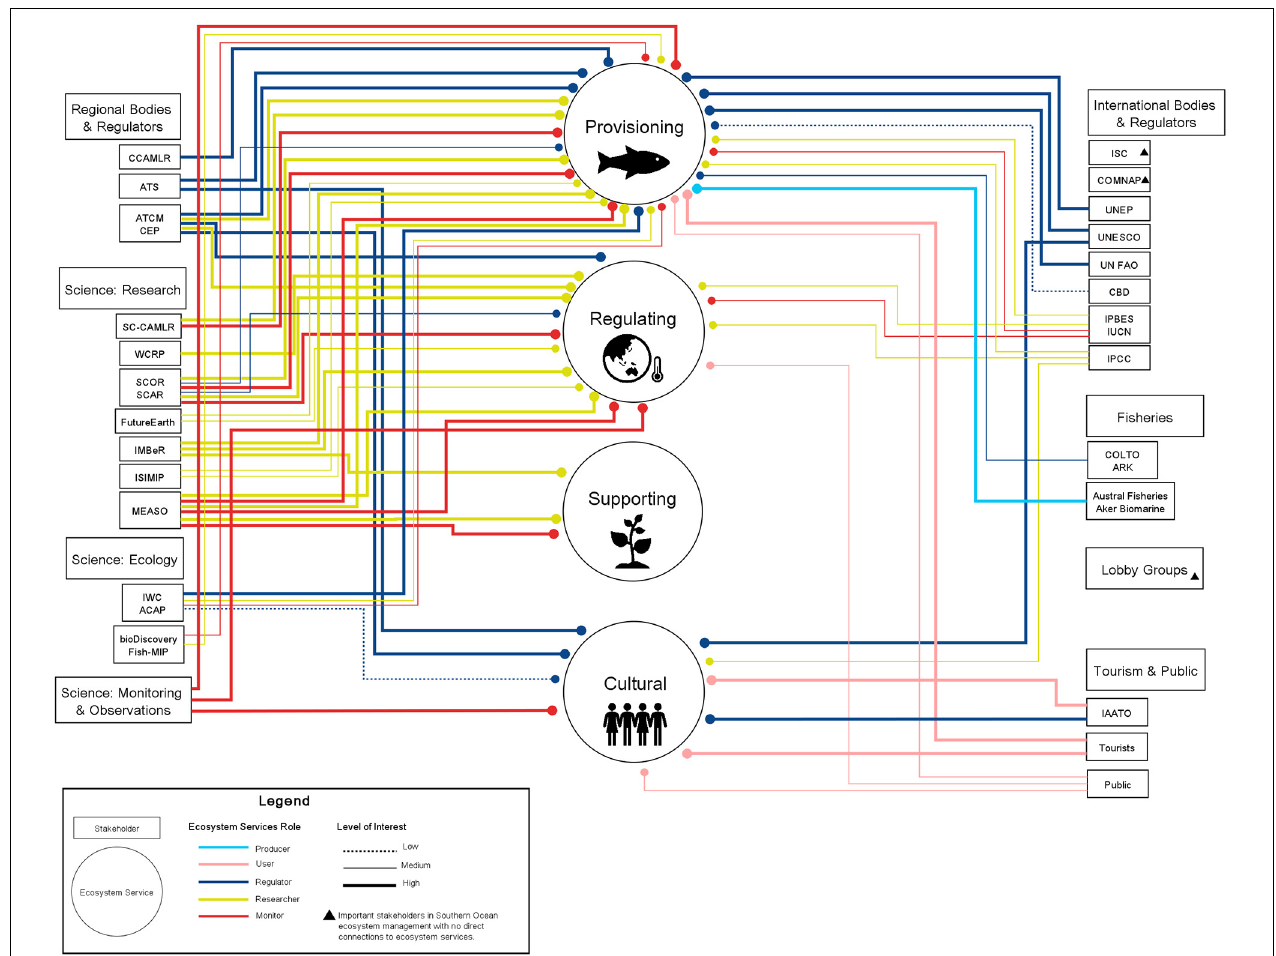
FIGURE 1 | A network visualization of the transactional landscape for stakeholders and ecosystem services in the Southern Ocean. Colored lines show the role that stakeholders perform, with respect to each service they are connected to, and the weight of the lines represents their relative level of interest in a particular